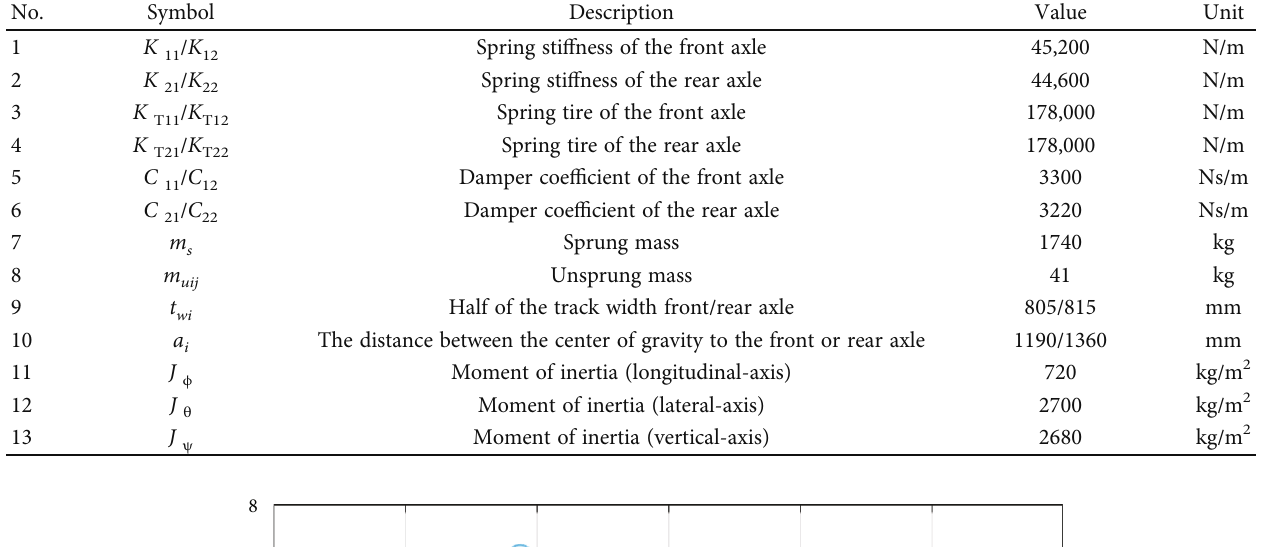
Table 1: The simulation parameters.